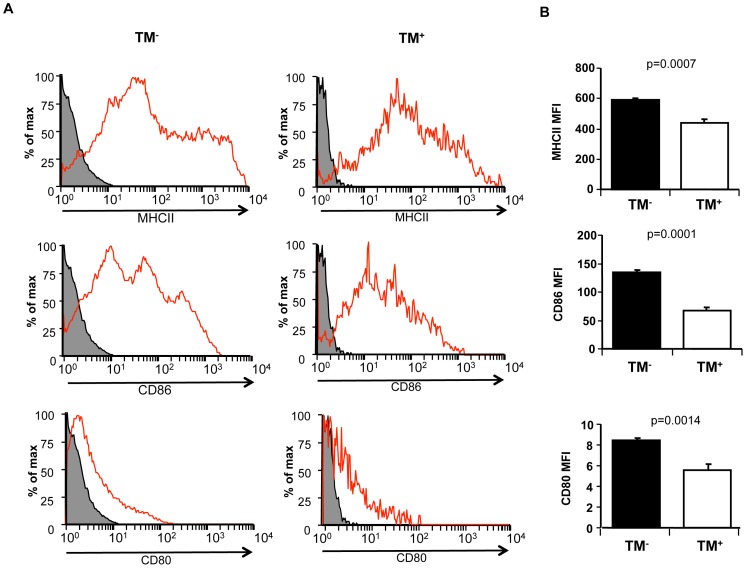
TM+ DCs from control cultures have lower expression of maturation markers than TM− DCs.Mouse DC cultures were sorted into TM+ and TM− DCs before analysis of MHC II, CD80 and CD86 expression by flow cytometry. (A) Representative experiment is shown with isotype control in gray. (B) The mean fluorescent intensity (MFI) from three independent experiments is shown. Error bars indicate s.d.